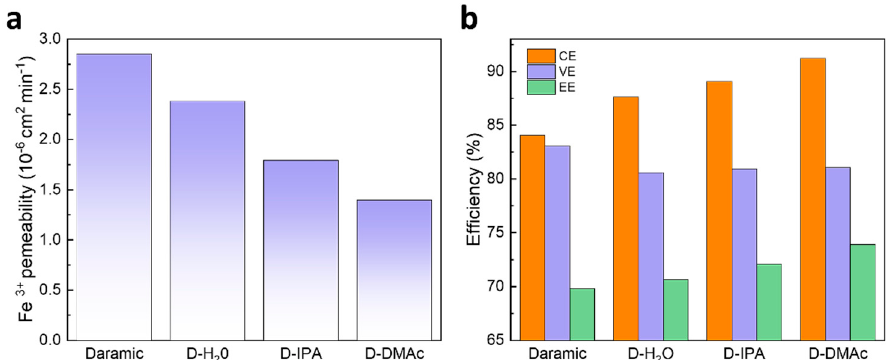
Figure 1. ( a ) Iron ion permeability of Daramic, D-H 2 O, D-IPA, and D-DMAc membranes; ( b ) The performance of ICFBs with Daramic, D-H 2 O, D-IPA, and D-DMAc membranes at the current density of 80 mA cm − 2 .